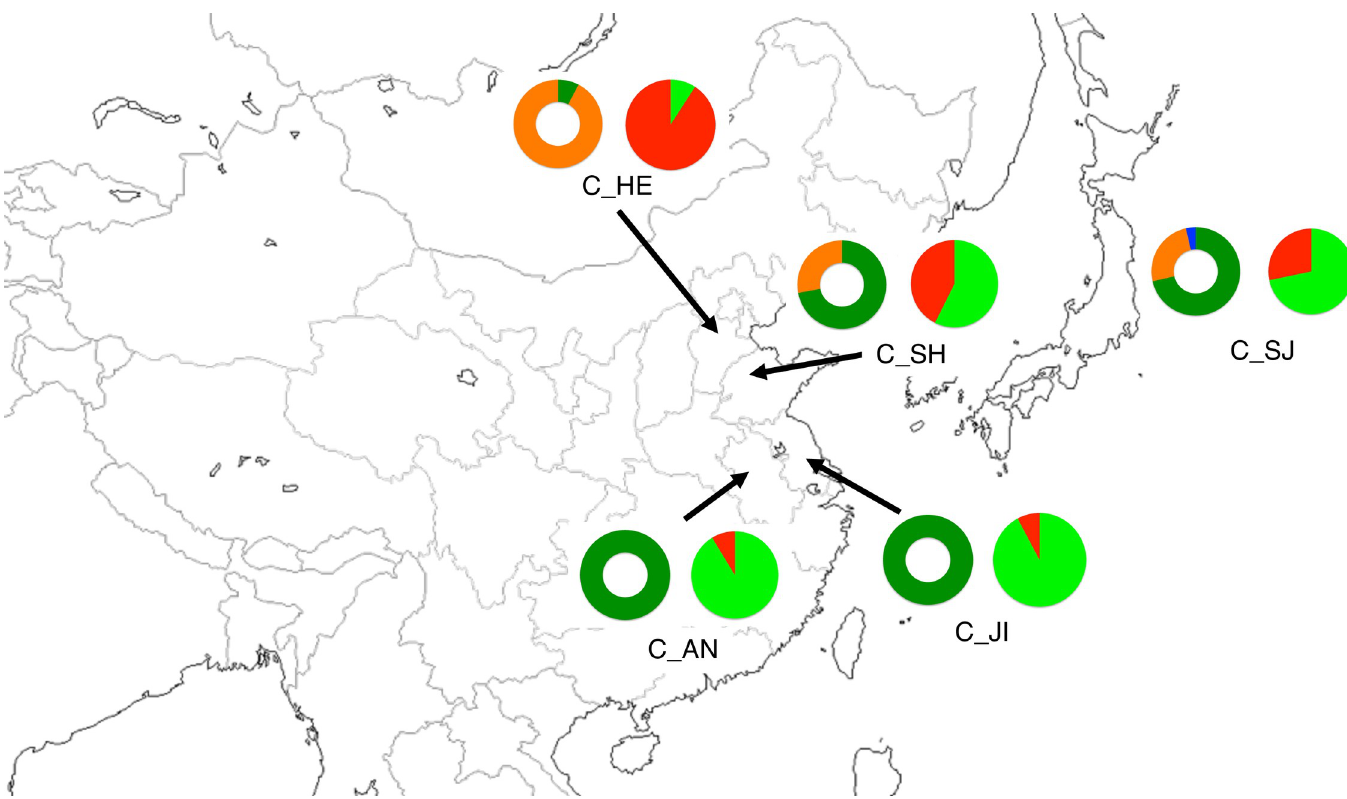
Fig 3. Geographic locations of Chinese chestnut cultivar groups and genetic structures. Donut and pie charts indicate composition of chloroplast haplotypes and clusters identified in STRUCTURE, respectively. The green, orange, and blue in the donut charts indicate HAP3, HAP4, and HAP5, respectively. The colors for the pie charts are based on the results shown in Fig 2.